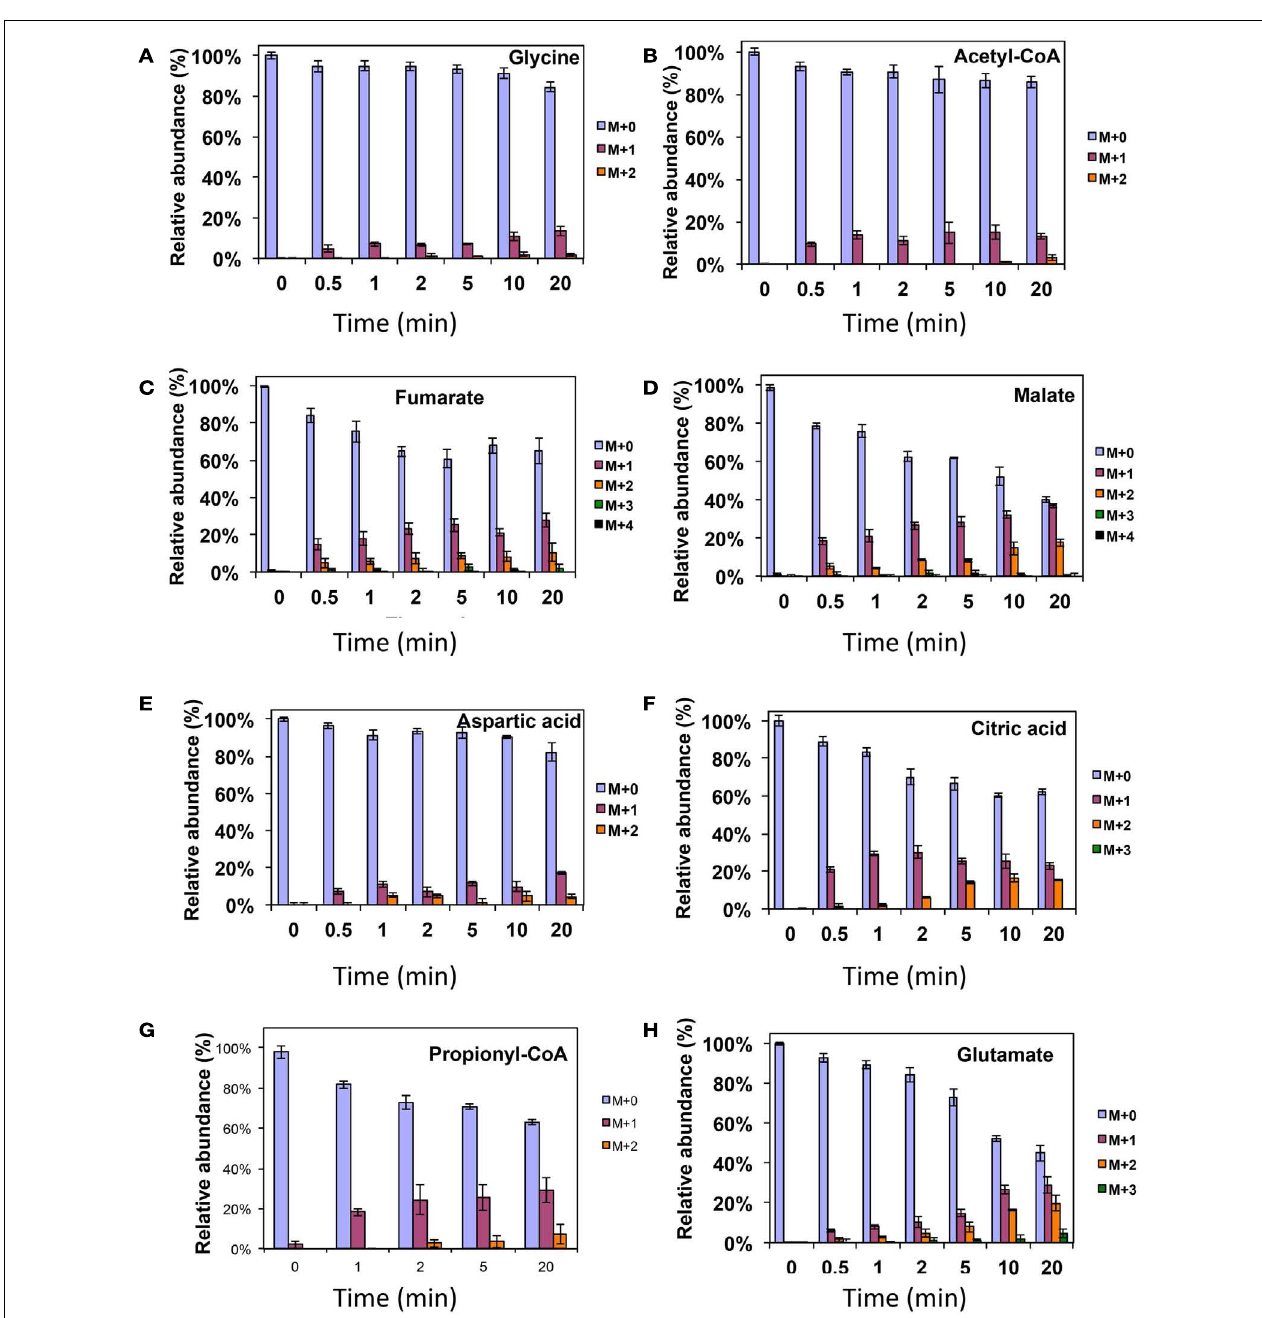
Additional data are shown in FigureA2 in Appendix. M + 0 represented non-labeled compound, M + 1 represented compound with one 13 C-label, M + 2 represented compound with two 13 C-labels and so